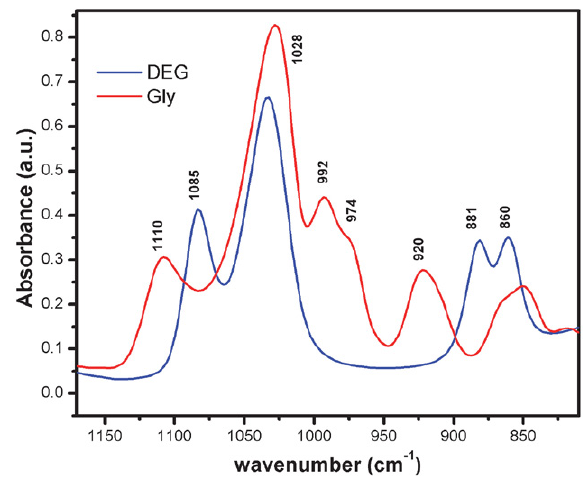
Figure 1: IR spectra of neat glycerin (red) and DEG (blue) in the spectral range 810–1170 cm –1 . The characteristic bands are labeled by the wavenumbers at band